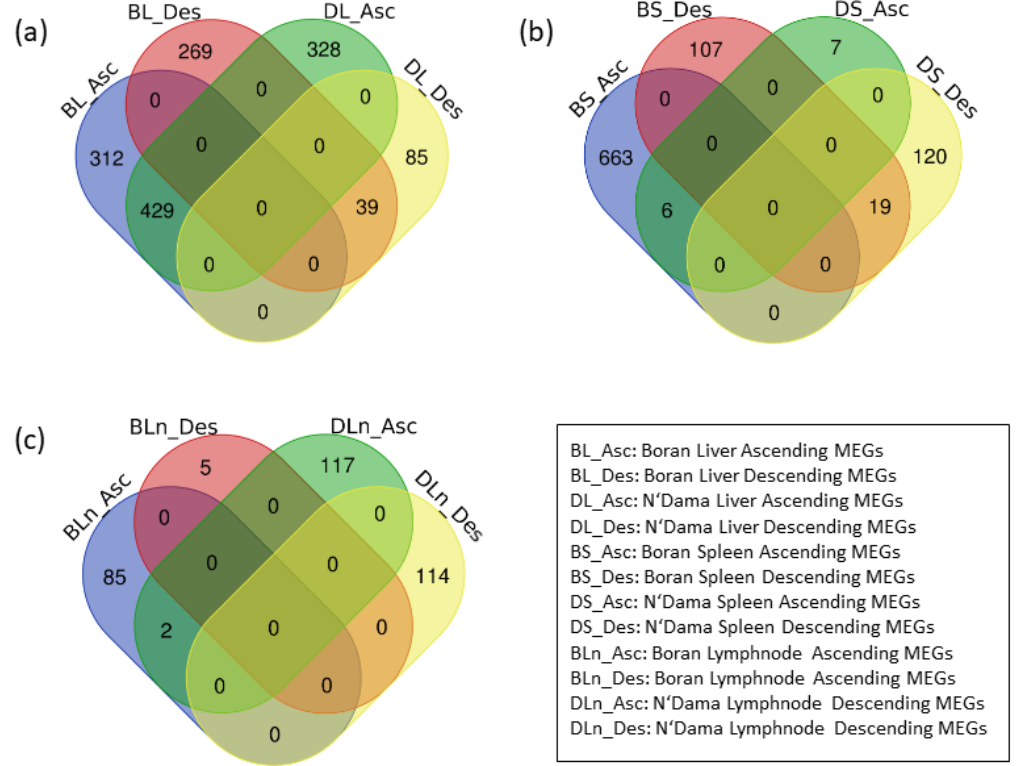
Figure 2. Venn-diagram of the MEGs in the ascending and descending orders of ( a ) liver-, ( b ) spleen- and ( c ) lymph node tissues for the progressive three time points (day 0, day 21, and day 35) after trypanosomiasis infection of the two cattle